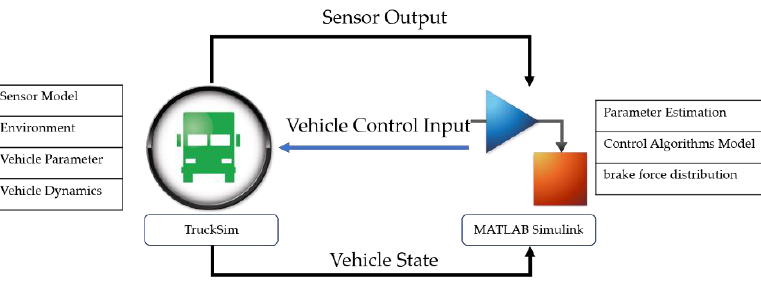
Figure 2. AEBS simulation platform architecture.